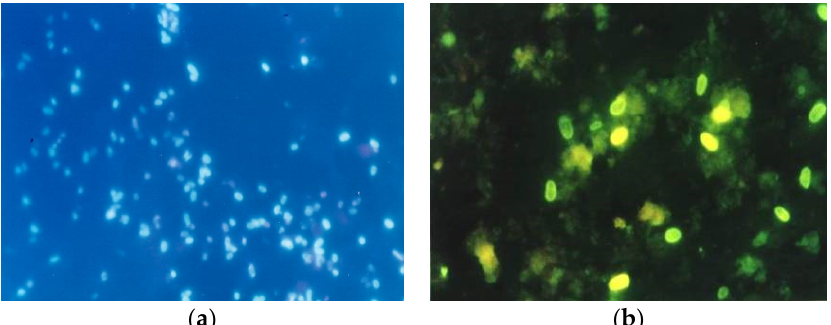
Figure 5. Microsporidia spores: ( a ): sample stained with calcofluoride—blue fluorescence ( b ): sample on the right stained with Rylux—green fluorescence.